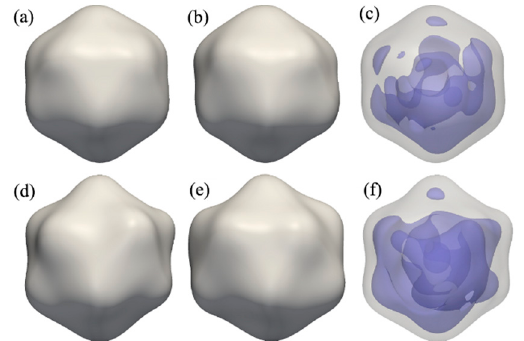
Figure 11. Three-dimensional reconstructed images of RDV (top row) and PR772 virus (bottom row). Two different views of the reconstructed RDV ( a , b ) and PR772 ( d , e ) particles, as well as density plots showing nonuniformities in the internal distribution of material inside the viruses ( c , f ). (reproduced with permission from [207]. Copyright American Physical Society, 2017).